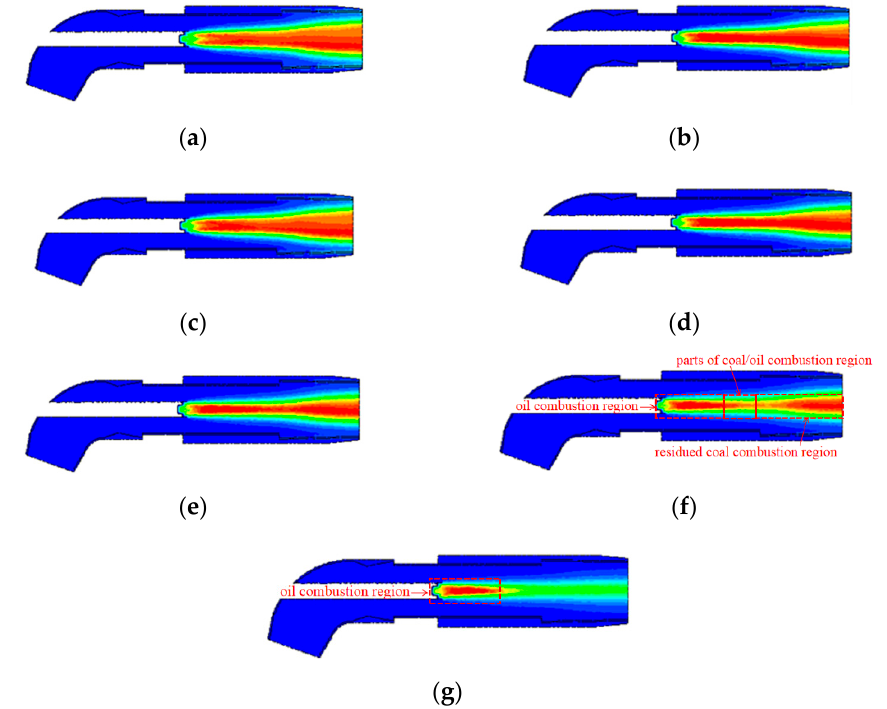
Figure 13. Temperature field at the longitudinal cross section (XZ central cross section) for different oil feed rates when the extension distance was 400 mm (K). ( a ) 160 kg/h, ( b ) 140 kg/h, ( c ) 120 kg/h, ( d ) 100 kg/h, ( e ) 80 kg/h, ( f ) 70 kg/h, ( g ) 60